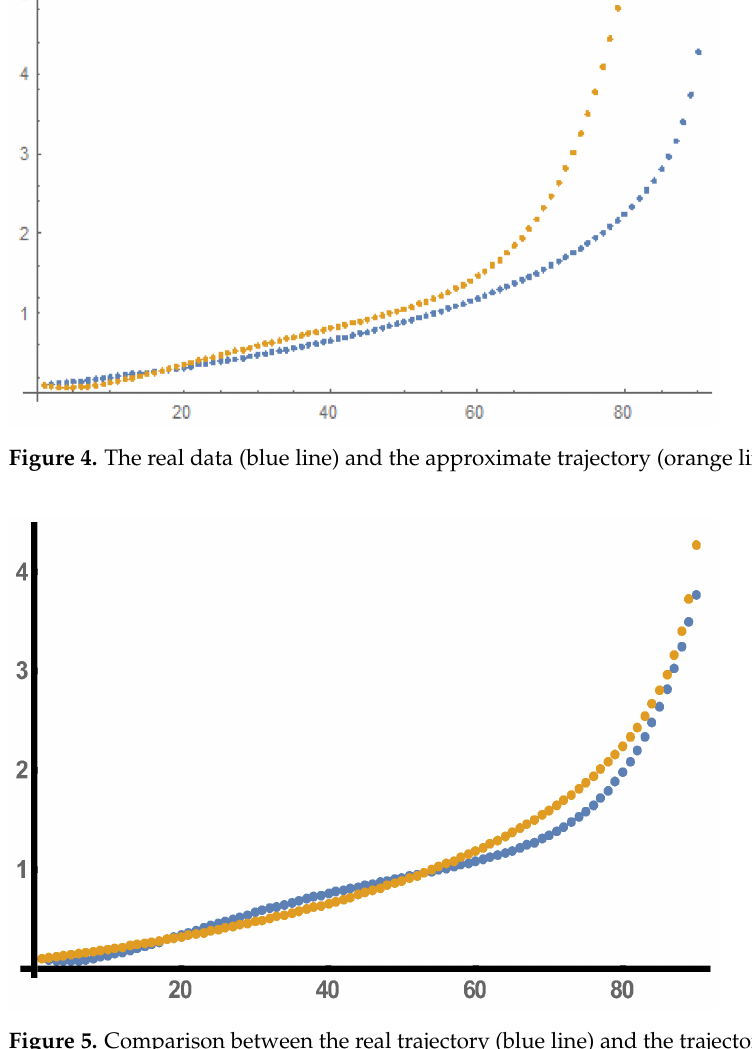
Figure 5. Comparison between the real trajectory (blue line) and the trajectory (orange line) given by the EDMD algorithm with a dictionary of five